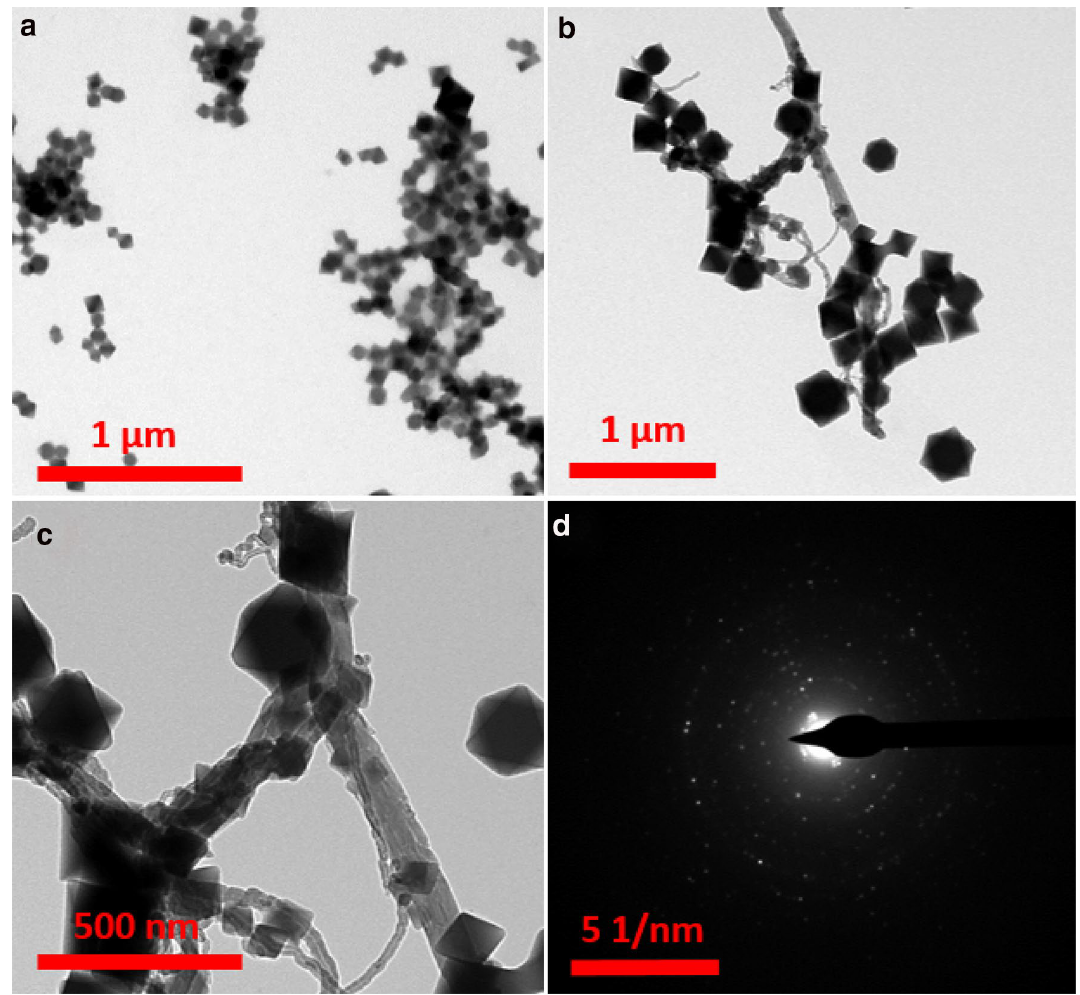
Figure 2. TEM images of ( a ) UiO-66-NH 2 nanoparticles, ( b , c ) UiO-66-NH 2 /CNTs hybrid nanocomposite with two different magnifications, and ( d ) electron diffraction of hybrid